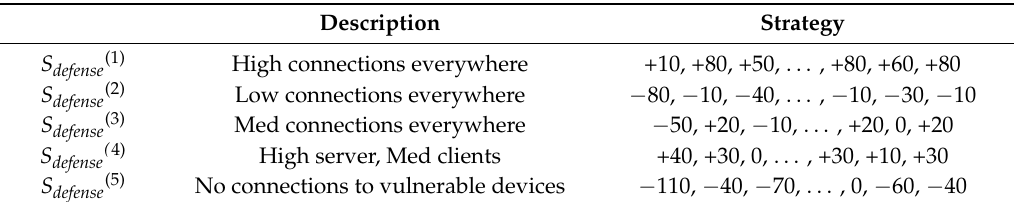
Table 1. Defense Strategies.